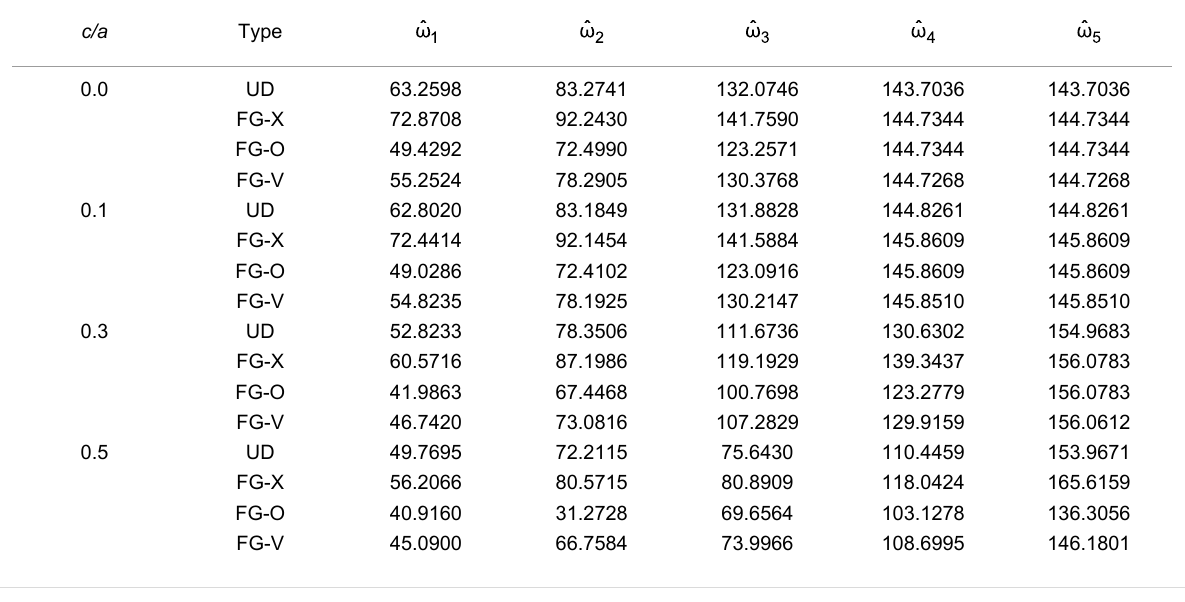
Table 10: First five natural frequency parameters for square, FG-CNTRC, SSSS plates with a centric cutout. Geometrical characteristics of the plate are a/b = 1, h/a = 0.05 with various c/a ratios. The volume fraction of CNTs is set equal to 0.17.